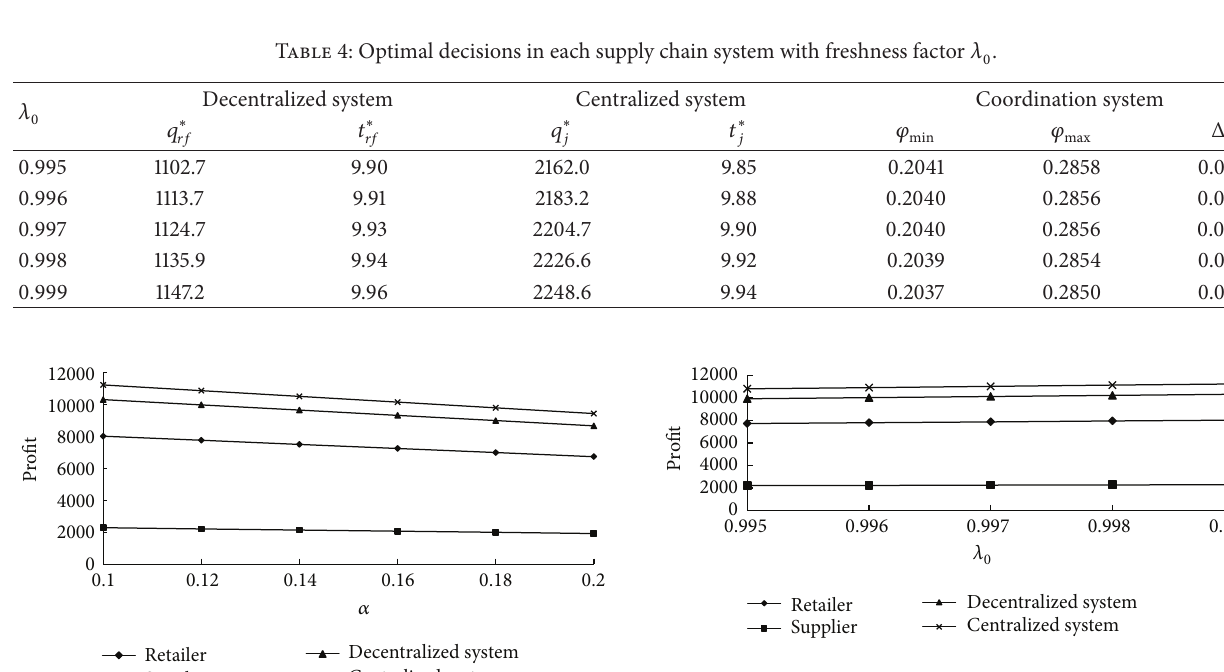
Figure 3: Profits of supply chain parties with freshness factor 𝜆 0